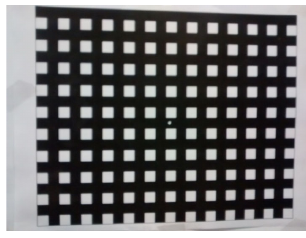
Figure 10. Grid pattern with 2 cm period.